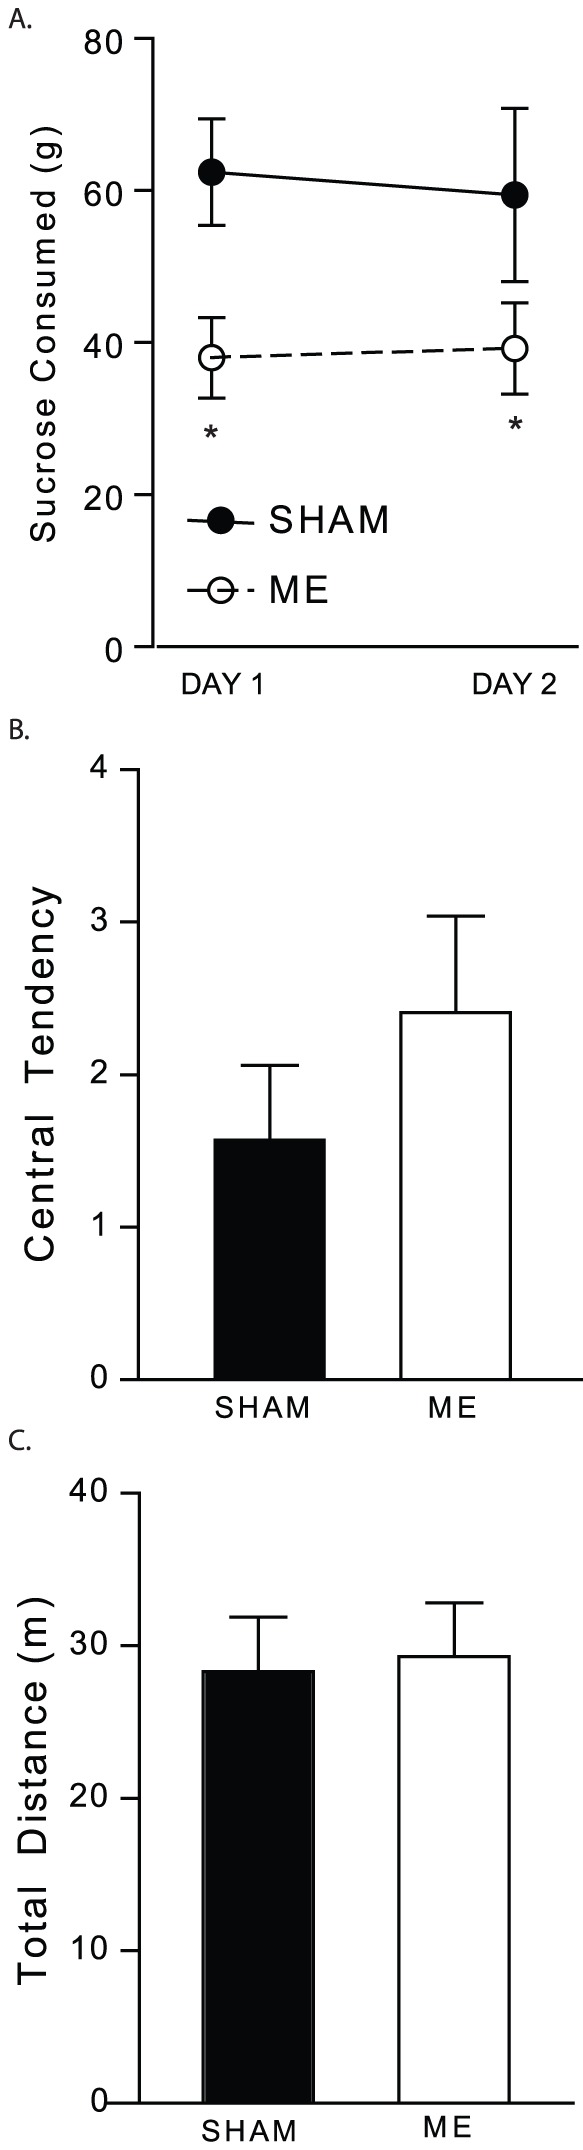
Aged SHAM and ME animals were evaluated in the sucrose consumption test and open field for depressive- and anxiety-like behaviors, respectively.(A) Aged ME animals in the sucrose consumption test consumed less sucrose over a two day period compared to aged SHAM animals (* indicates P<0.05). (B,C) In the open field, no differences existed in the time spent in the center of the arena, or in the total distance traveled between aged SHAM and ME animals. SHAM n = 7; ME n = 9. Error bars indicate standard error of mean (S.E.M.).